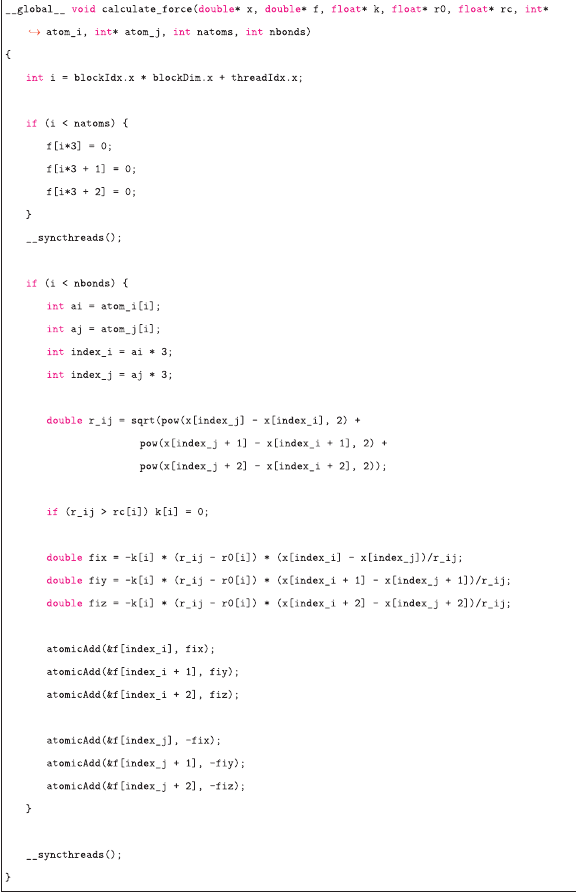
Frontiers in Materials |